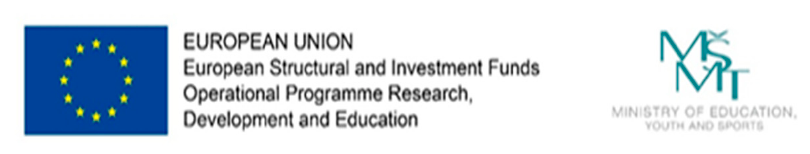
fragments by MS, Figure S5: Evolution of NH 3 gas fragments by MS, Figure S6: Evolution of N 2 gas fragments by MS, Figure S7: Evolution of H 2 O fragments by MS, Figure S8: Evolution of CO 2 gas fragments by MS, Figure S9: Evolution of CO gas fragments by MS, Figure S10: Evolution of SO 2 gas fragments by